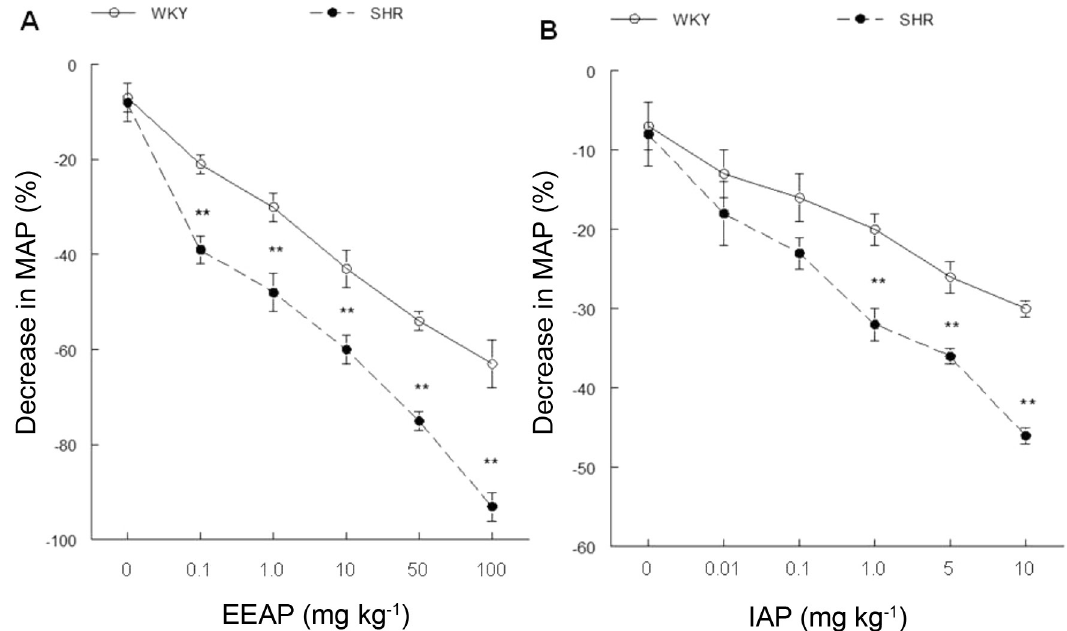
FIGURE 4 - Percentage decrease in MAP after injection of saline (1 mL kg -1 ) and increasing doses of EEAP (0.1–100 mg kg -1 ; Panel A) and IAP (0.01–10 mg kg -1 ; Panel B). Values are expressed as the mean ± SEM. ** p < 0.01 compared with WKY